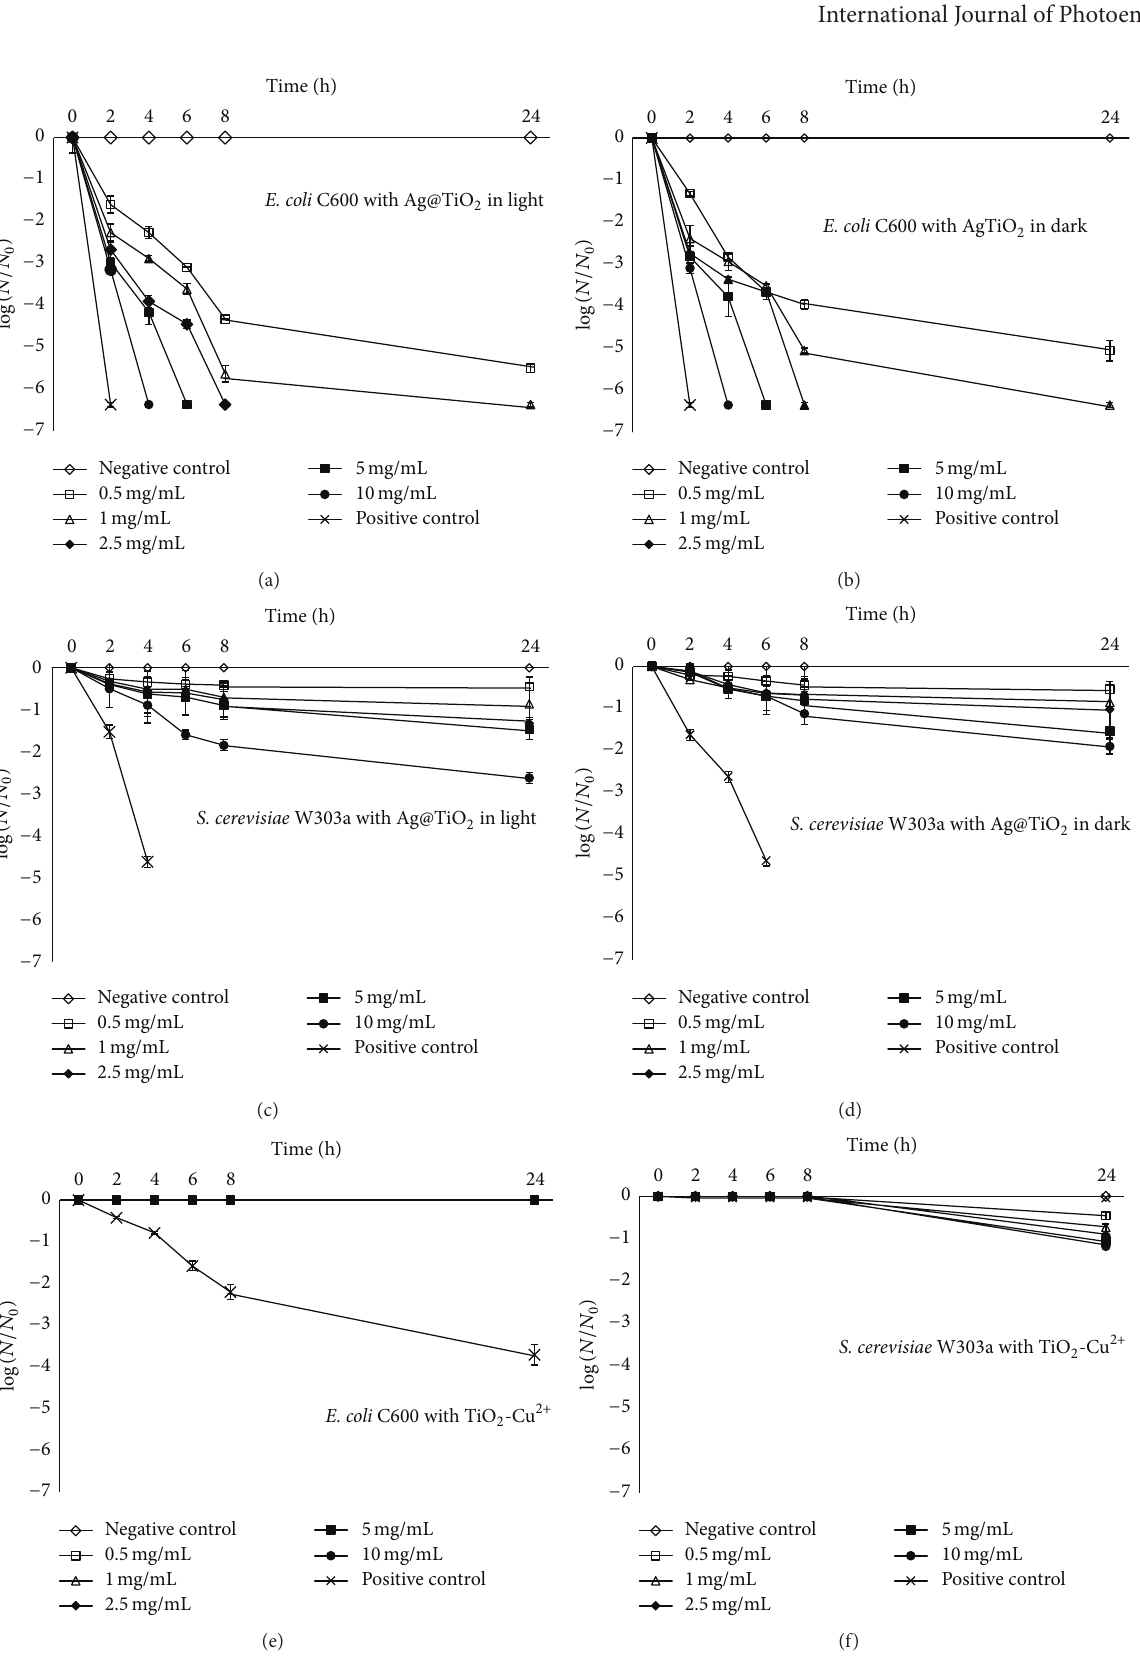
Figure 2: Inactivation of microorganisms by NSMs: E. coli with Ag@TiO 2 (a) under visible light and (b) in dark; S. cerevisiae with Ag@TiO 2 (c) under visible light and (d) in dark; (e) E. coli with TiO 2 -Cu 2+ ; (f) S. cerevisiae with TiO 2 -Cu 2+ . As positive control, Ag 0 for Ag@TiO 2 and CuSO 4 for TiO 2 -Cu 2+ . Bars represent standard deviation; each treatment was performed in